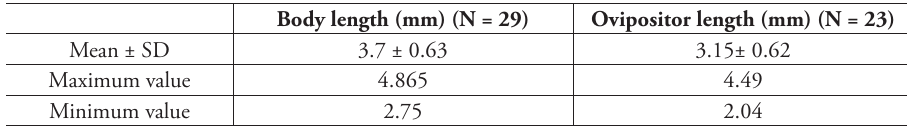
Table 1. Body size variability of the Rhoptrocentrus piceus specimens emerged from larvae of Psacothea hilaris hilaris